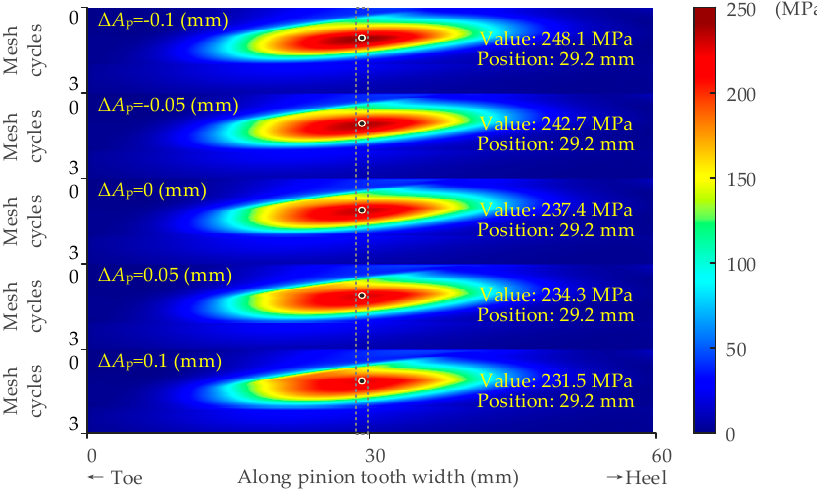
Figure 12. Variation of tooth root stress in three mesh cycles considering the variation of pinion axial error.